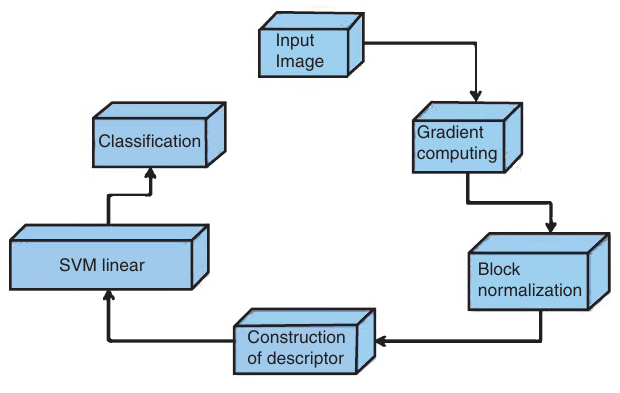
Fig. 10. Feature extraction and classification using HOG and a